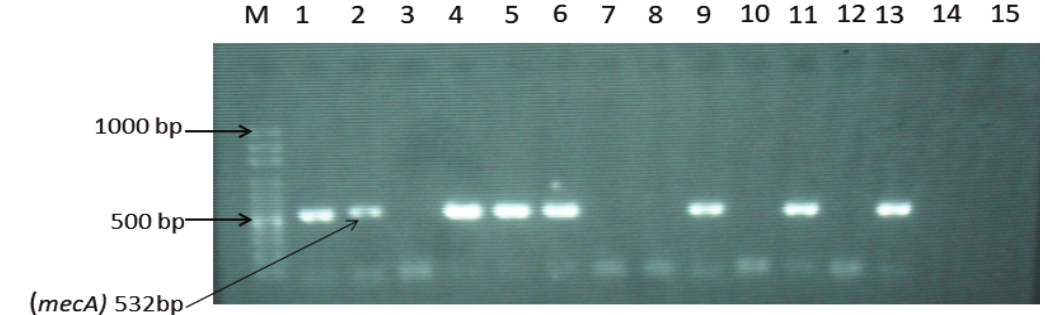
Figure 2: Detection of mecA gene by PCR in 1.5% agarose gel electrophoresis. M: 100 bp molecular ladder; lane (1 & 13): positive control; lane 2: isolate 131; lane 3: isolate 174; lane 4: isolate 175; lane 5: isolate 176; lane 6: isolate 177; lane 7: isolate 178; lane 8: isolate 179; lane 9: isolate 180; lane 10: isolate 181; lane 11: 182; lane 12: negative control. (Isolates 131, 175, 176, 177, 180, and 182 were mecA gene positive (MRSA) with product size 532 bp, while isolates 174, 178, 179 and 181 were mecA gene negative